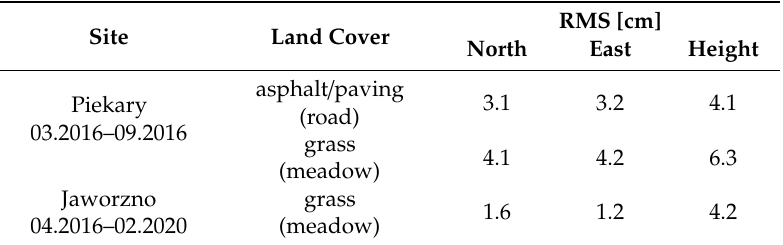
Table 3. RMS displacement determination